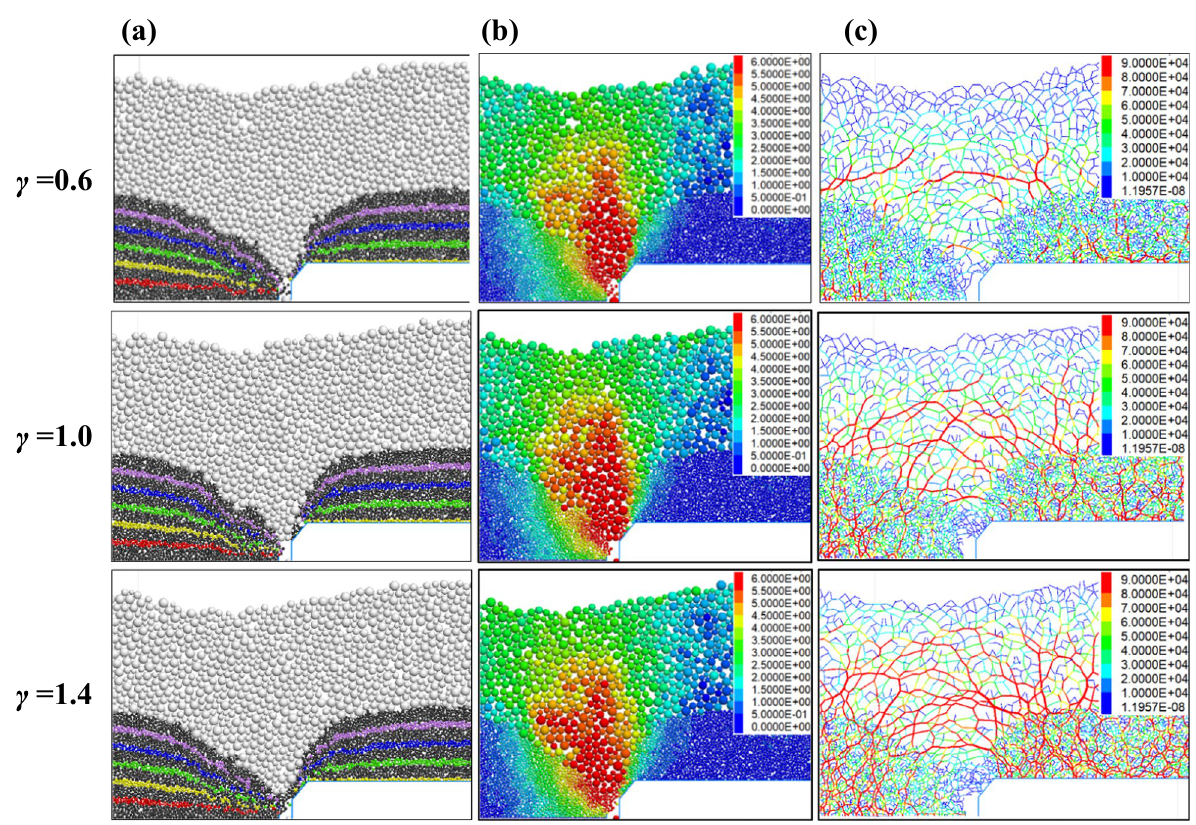
Fig. 16 a Shape of the boundary, b Displacement field diagram (unit: m); and c Force chain diagram (unit: N) in the initial drawing stage for dif- ferent γ